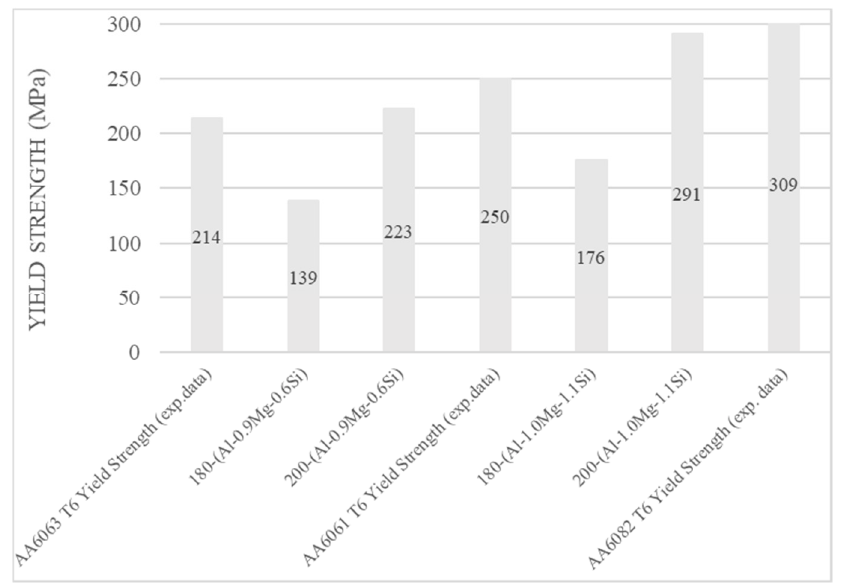
Figure 16. Yield strength estimation. Experimental data (AA6061-AA6063-AA6082) from